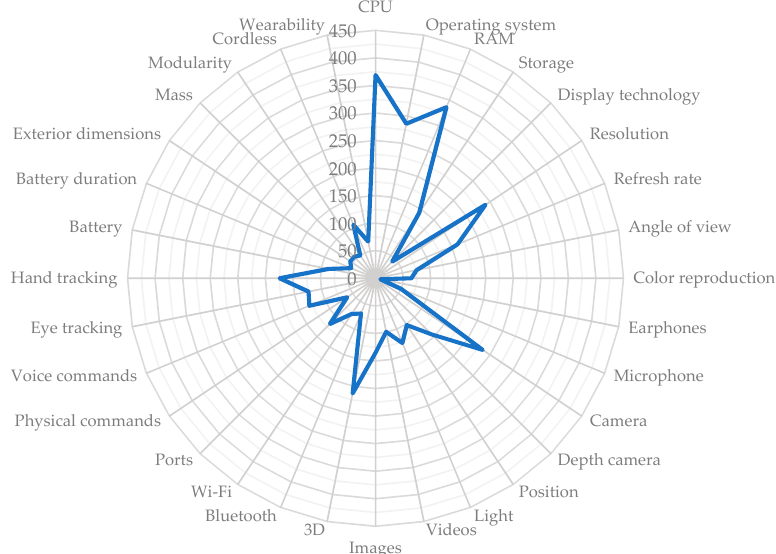
Figure 4. Device specification relative importance for orthognathic surgery. The following chart (Figure 5) shows which devices are better to fulfil the requirements of the orthognathic scenario. The best-case device is represented as a white background element to improve the contrast with the market devices coloured lines; this makes it easier to identify the best-performing devices. The worst performance, like the previous scenarios, is achieved in the sensors field.